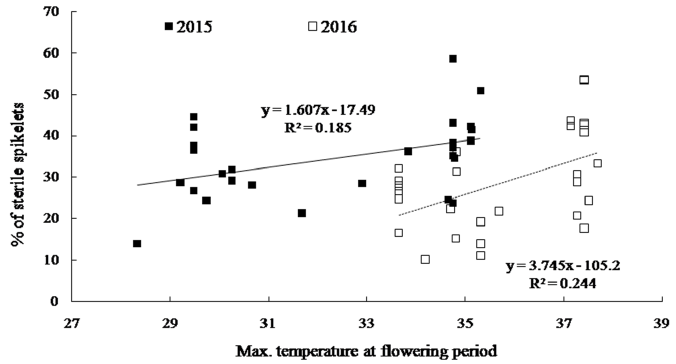
Figure 5. The correlation between the percentage of sterile spikelets and the maximum temperature at the flowering period. The maximum temperature at the flowering period was recorded between two days before and after heading in 2015 and 2016.